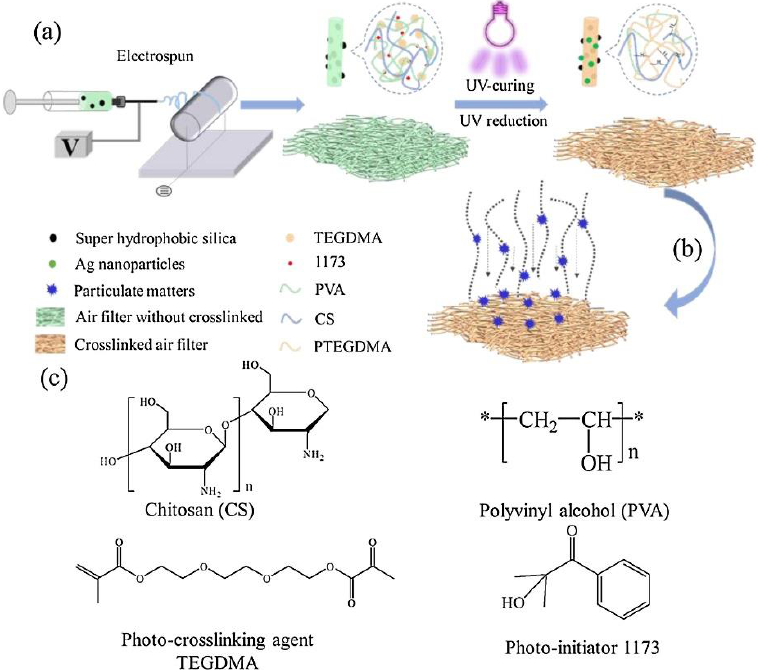
Figure 6. Example of green electrospinning process combined with UV treatment [178]. Fabrication process for antibacterial and hierarchical CS-PVA nanofibrous membranes by combination of ( a ) electrospinning, one step UV reduction and cured. ( b ) Filtration process of the CS-PVA@SiO 2 NPs-Ag NPs air filtration membranes. ( c ) The chemical structure of CS/ PVA/TEGDMA/1173.